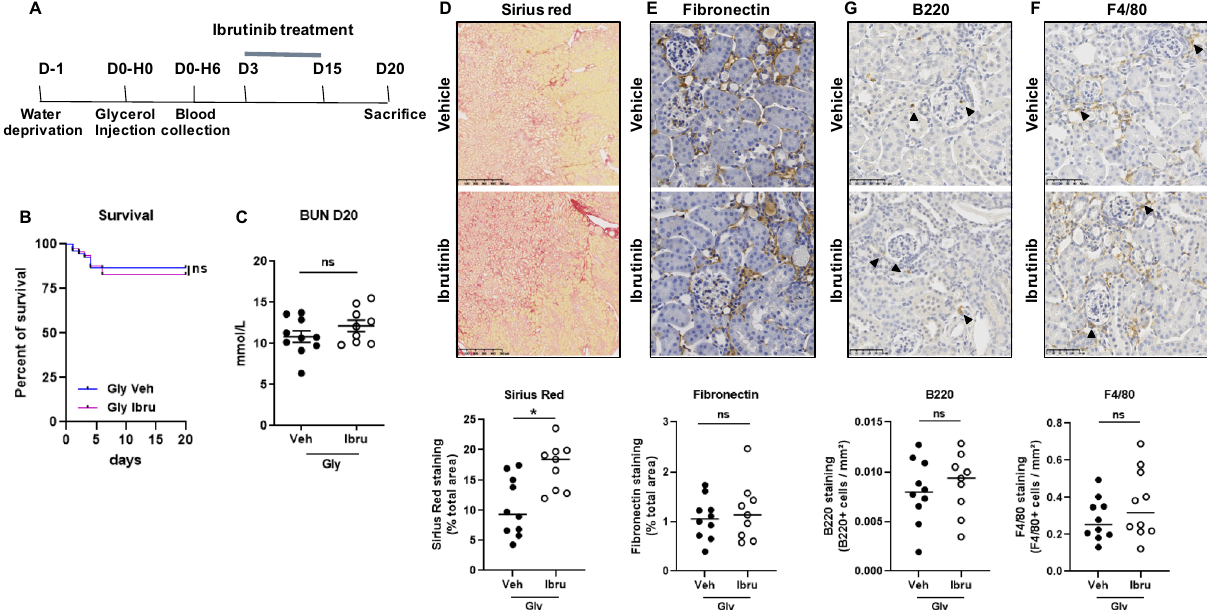
Figure 3. Ibrutinib promotes rhabdomyolysis-induced renal fibrosis. ( A ) Design of the study. ( B ) Kaplan– Meier survival curves after glycerol injection in mice receiving ibrutinib (Ibru) or vehicle (Veh) from day 3. ( C ) Blood urea nitrogen (BUN) 20 days after glycerol injection. ( D – G ) Representatives images and quantification of Sirius Red ( D ), Fibronectin ( E ), F4/80 ( F ) and B220 ( G ) staining 20 days after glycerol injection in mice receiving ibrutinib (Ibru) or vehicle (Veh) from day 3. Values are expressed as mean ± SEM. * p < 0.05, compared with the vehicle group (Mann–Whitney test, n = 5–10 mice); ns, not significant.